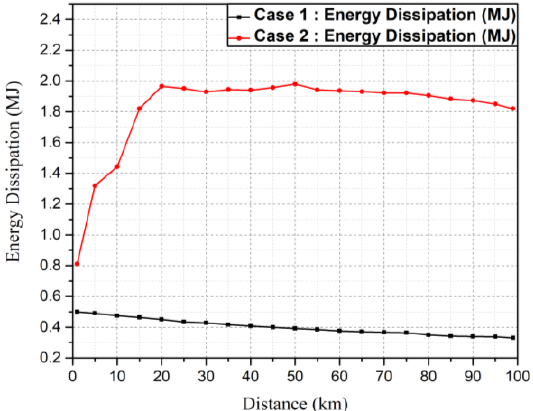
Figure 10. Comparison of energy dissipation on the circuit breaker (CB). Case-1 is an HCB; Case-2 is an RCB.